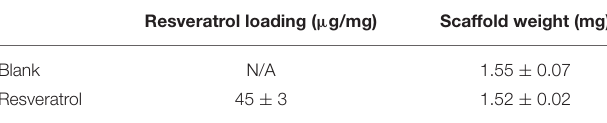
TABLE 1 | Resveratrol loading and scaffold